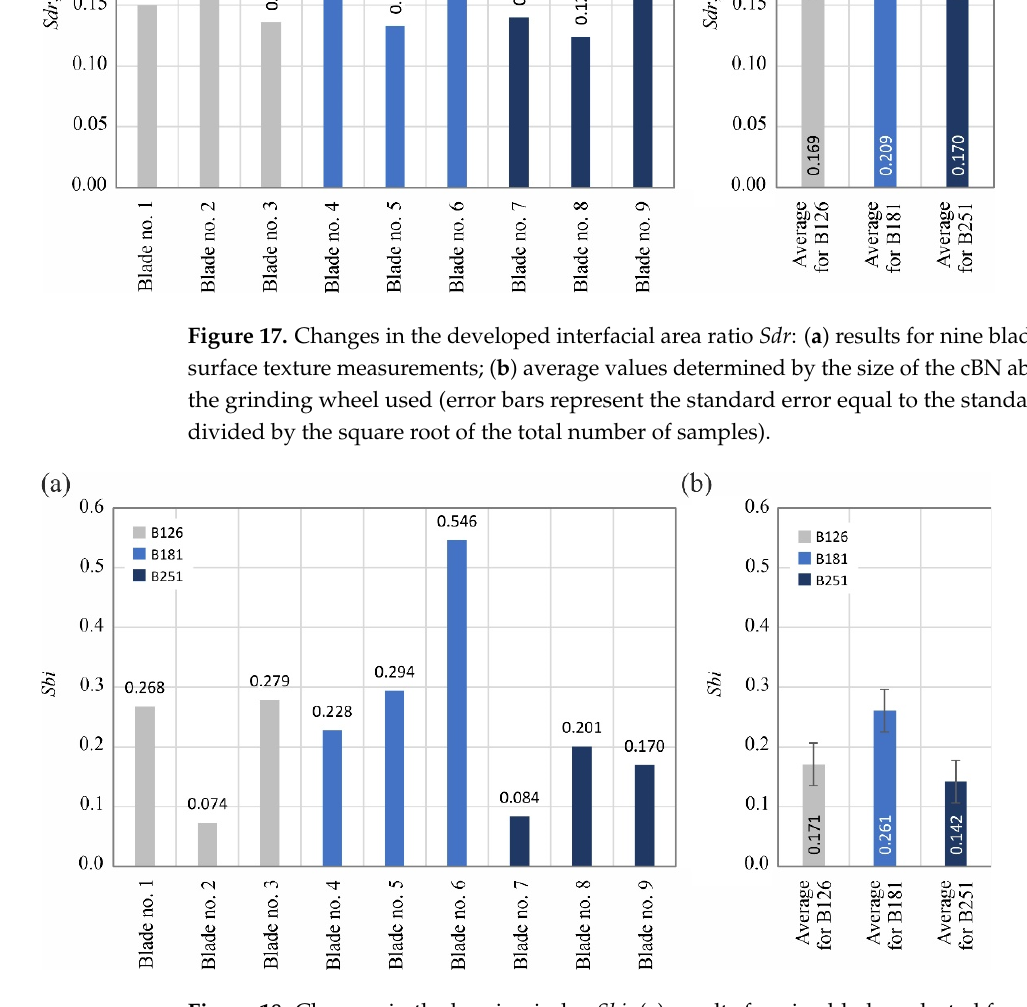
Figure 18. Changes in the bearing index Sbi : ( a ) results for nine blades selected for surface texture measurements; ( b ) average values determined by the size of the cBN abrasive grain of the grinding wheel used (error bars represent the standard error equal to the standard deviation σ divided by the square root of the total number of samples).